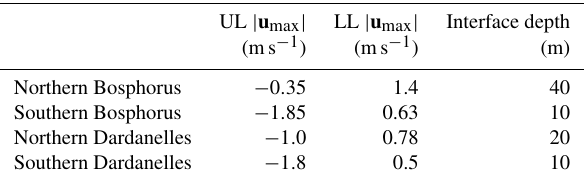
Table 3. Along-strait maximum velocity for the upper layer (UL) and lower layer (LL) and interface depth in each strait exit. Units are in ms − 1 and metres for the velocity and depth, respectively. A negative value indicates the flow in the direction from the Black Sea to the Aegean Sea. UL | u max | LL | u max | Interface